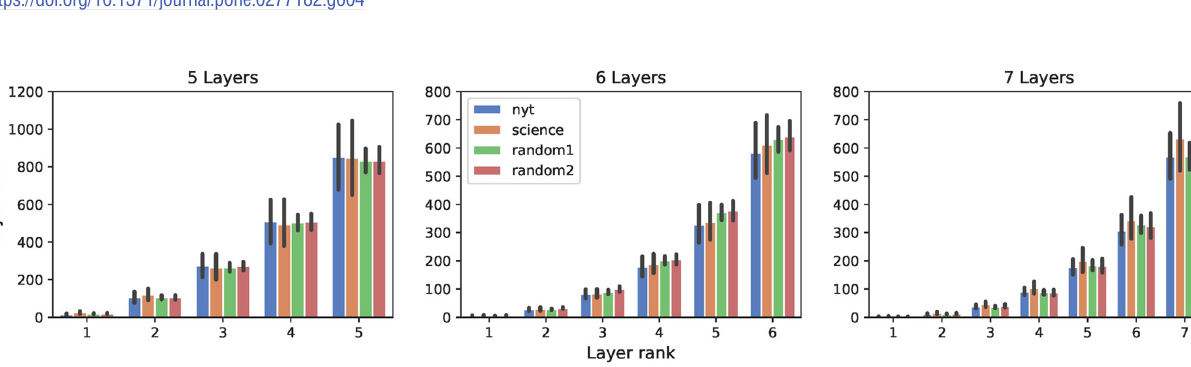
PLOS ONE | https://doi.org/10.1371/journal.pone.0277182 November22,